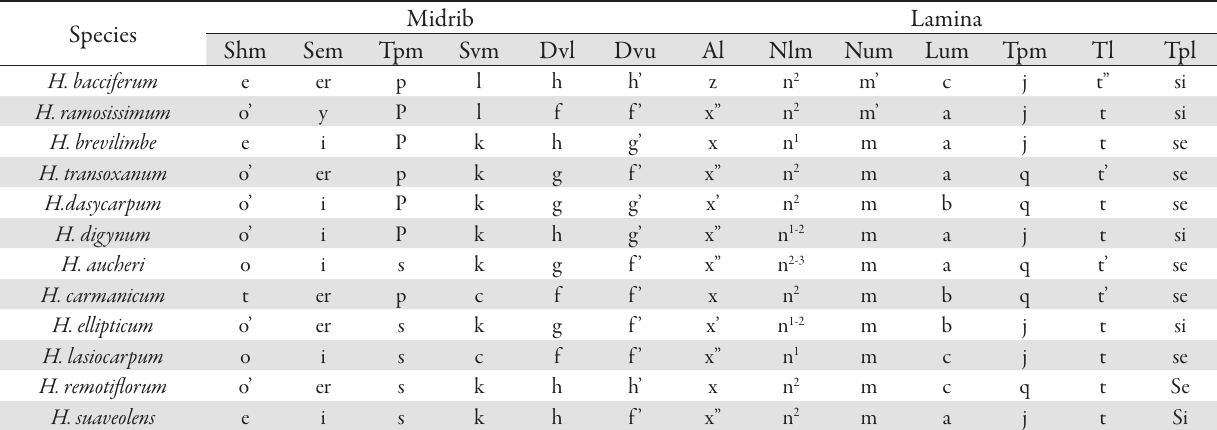
Tab. 2. Useful anatomical characters for distinguishing of species Species